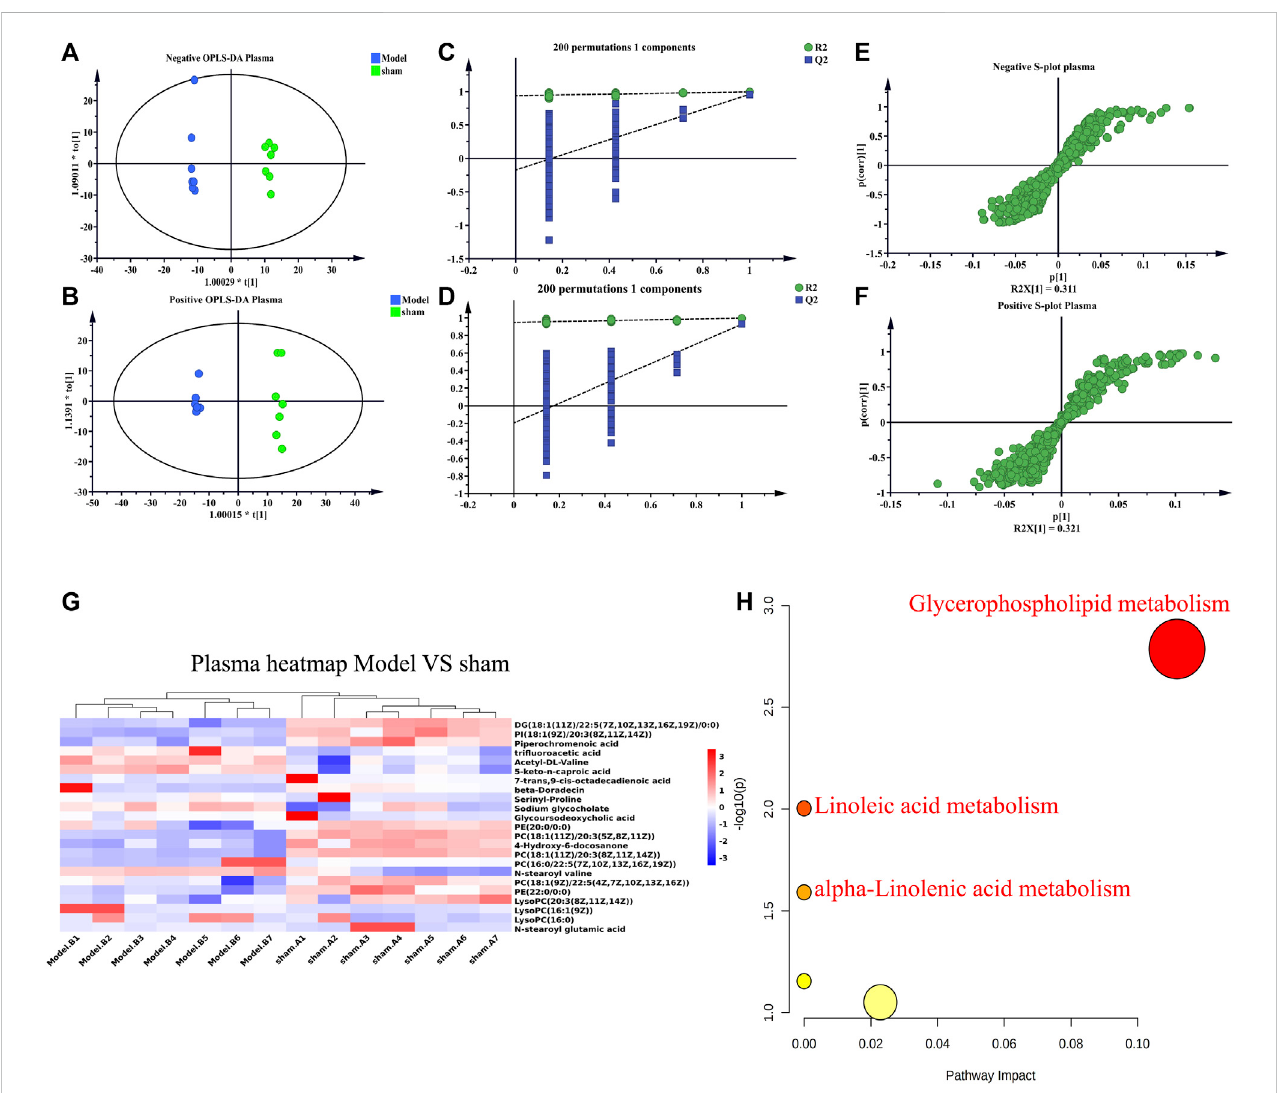
FIGURE 5 Multivariatestatisticalanalysisofplasmainshamandmodelgroupsofrats. (A – B) OPLS-DAscoreplotsofshamandmodelgroups. (C – D) Validationplots after 200 replacement tests. (E – F) S-plots of sham and model groups from the OPLS-DA model. (G) Heatmap of chronic heart failure rats. (H) Plots of metabolic pathways associated with chronic heart failure rats. (A, C, E) negative mode; (B, D, F) positive